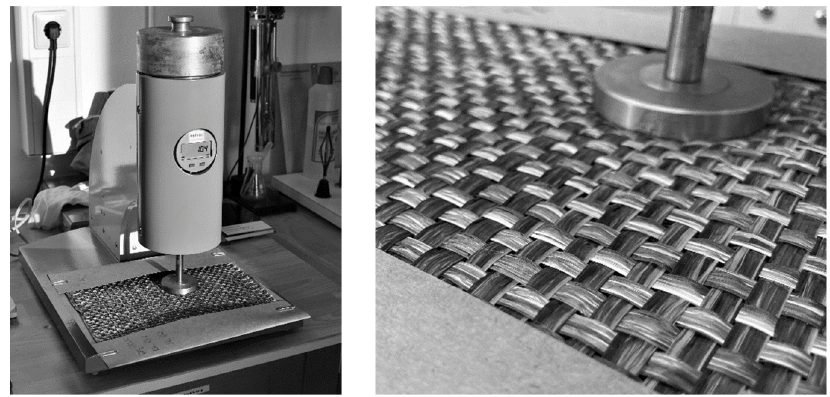
Figure 11 . Thickness measurement device rainbow (KARL SCHRÖDER/SYLVAC). Figure 11. Thickness measurement device rainbow (KARL